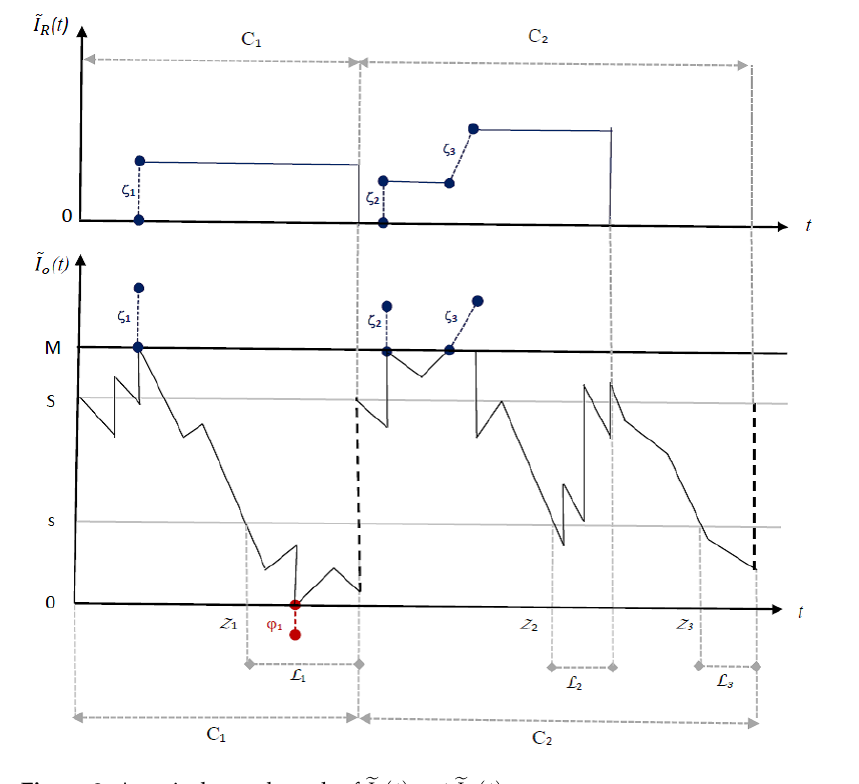
Figure 2. A typical sample path of (cid:101) I o ( t ) and (cid:101) I R ( t ) . The stock levels of PW and SW, (cid:101) I o ( t ) and (cid:101) I R ( t ) , are depicted in the bottom